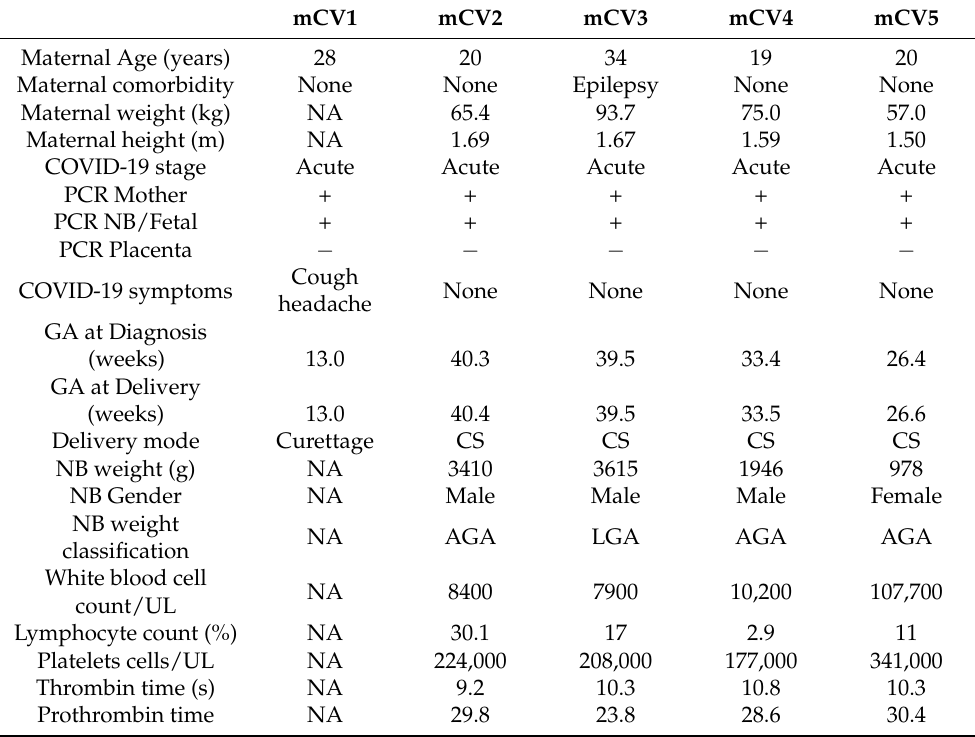
Table 2. Clinical data of women with mild COVID-19 and their newborns.